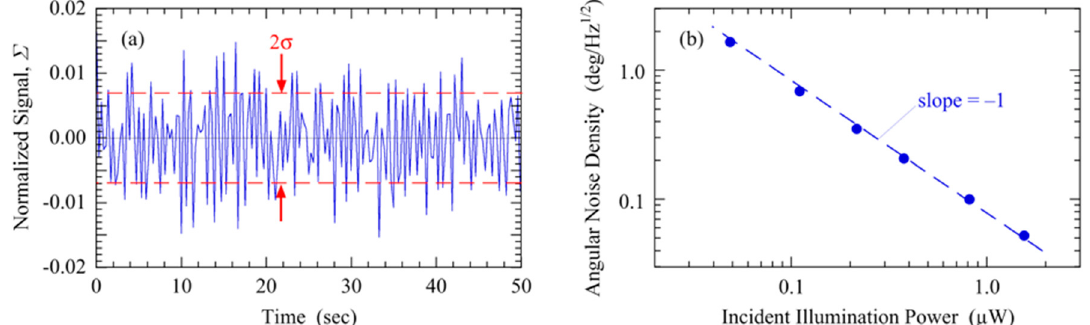
Figure 5. ( a ) Example time record of the normalized signal at θ in = 0°. ( b ) Log–log plot of angular noise density vs. incident illumination power from 660 nm light tag. Dashed line shows a slope of -1.